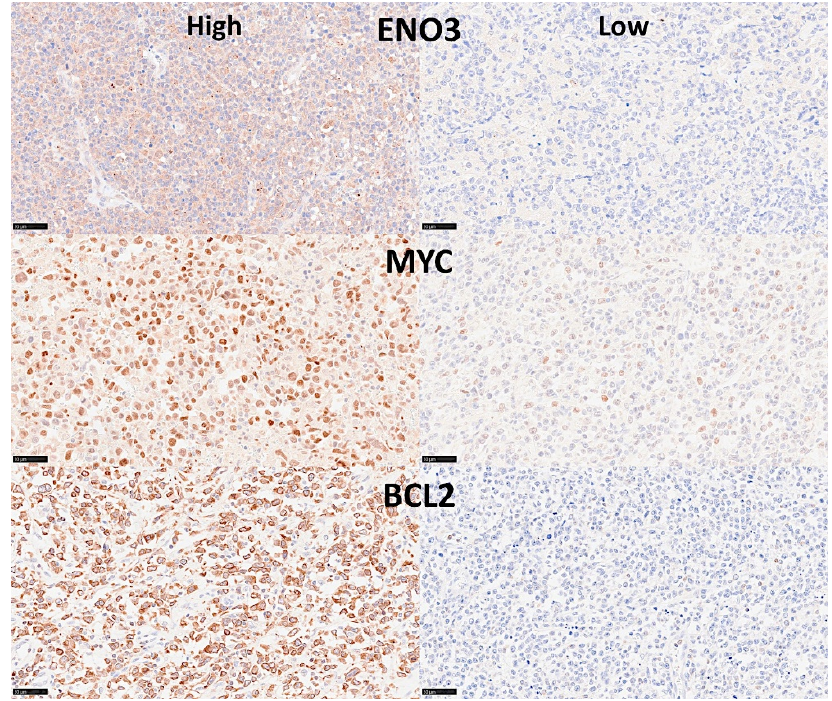
Figure 11. Immunohistochemical staining of ENO3, MYC, and BCL2 in diffuse large B-cell lymphoma. This figure shows six different lymphoma cases, with high or low expression of the 3 markers. Original magnification: 400× (scale bar = 50 um).